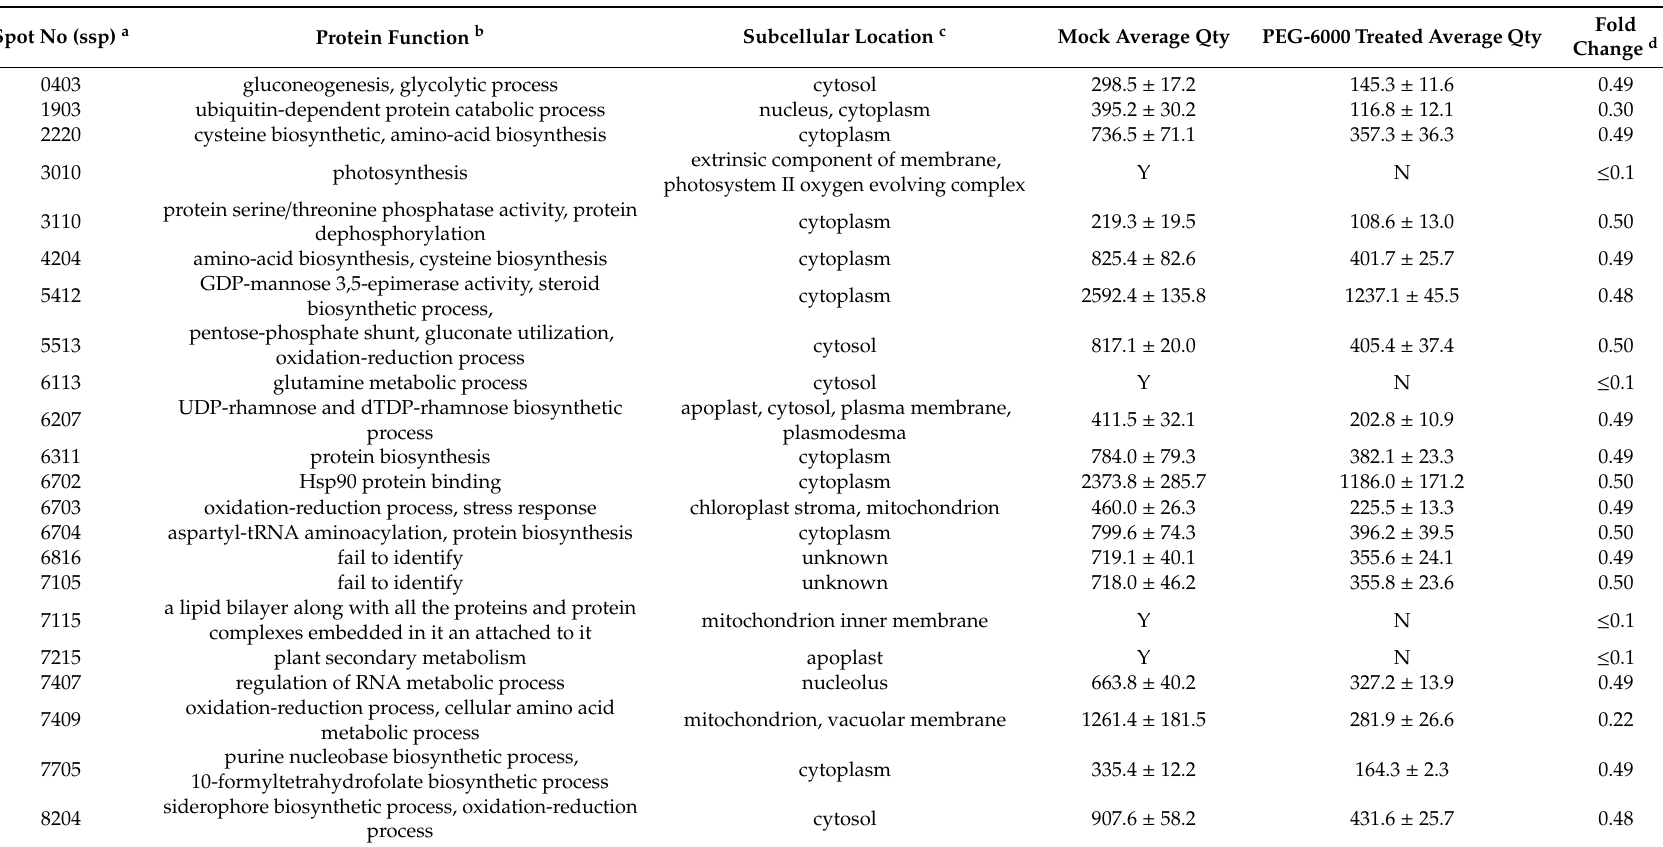
Table 3. Downregulated protein spots in root of sorghum seedlings treated with PEG-6000 imitation drought stress at 24 h posttreatment identified by Peptide Mass Fingerprint (PMF) query: the criteria of selection for identification was a 0.5-fold or lower change compared to the mock and a Mascot quality score of over 80. All values are means from three independent